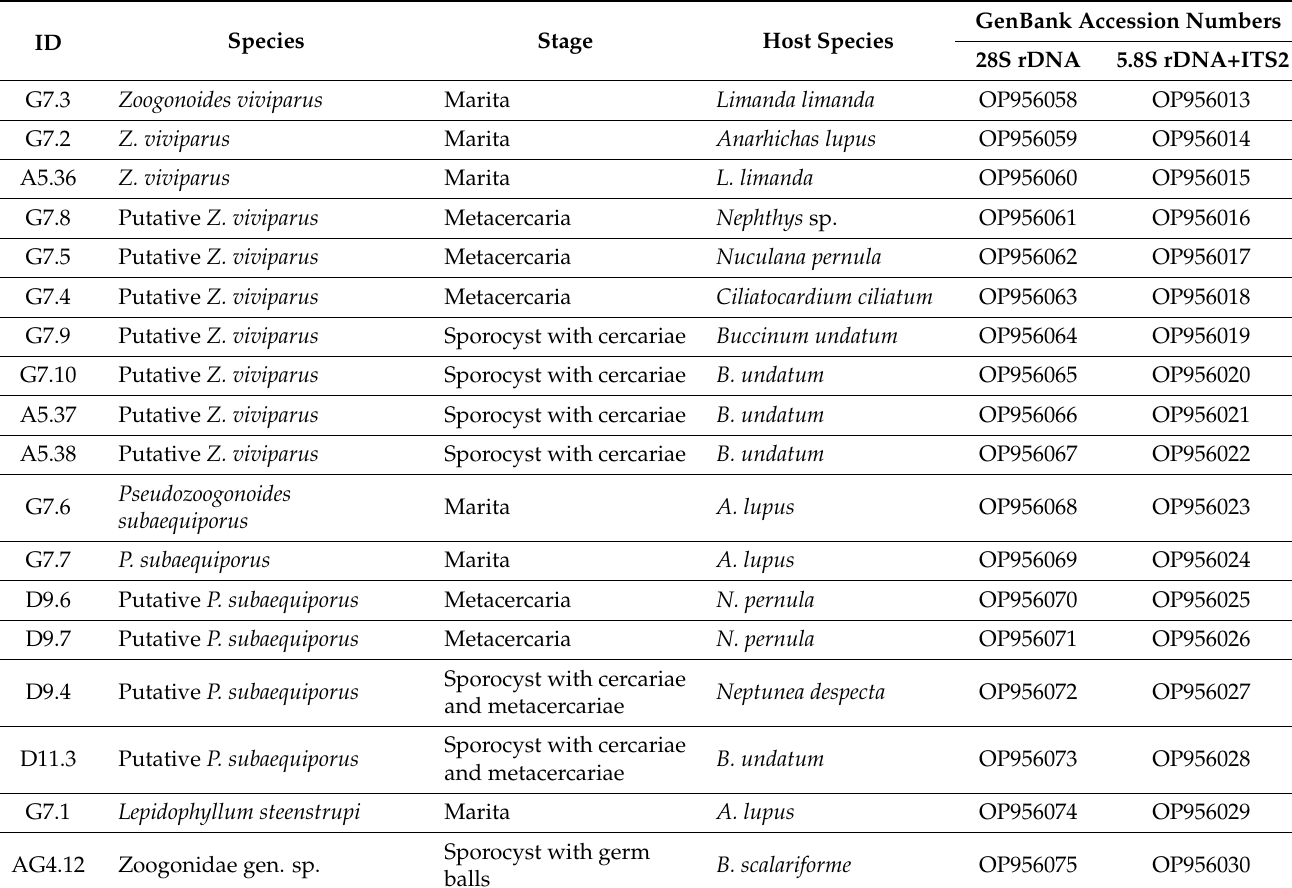
Table 2. Isolates of putative and identified Zoogonidae from the White Sea, their origin and GenBank accession numbers.